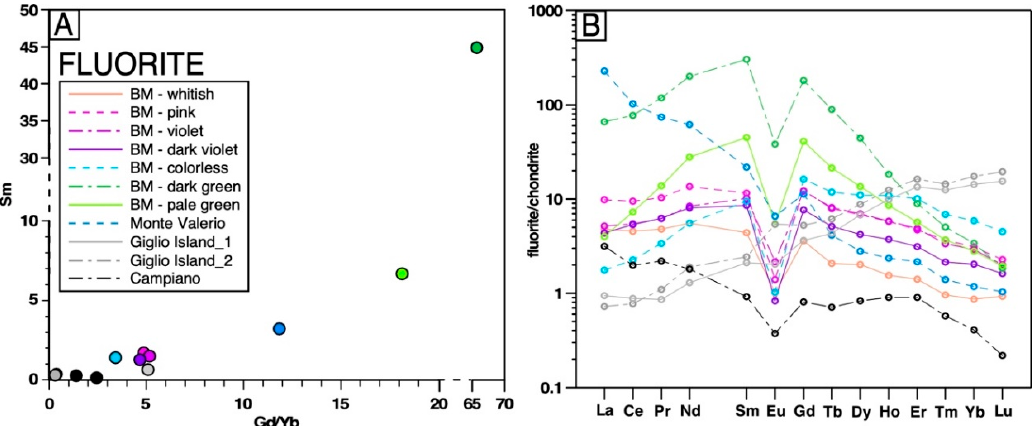
Figure 13. ( A ) Sm vs. Gd/Yb diagram showing an overall positive correlation, with higher values in the green crystals. ( B ) Chondrite normalized REE pattern for fluorite from the Campiglia system. Monte Valerio and Giglio Island fluorite are analyzed for comparison. Colors of symbols and lines correspond to fluorite crystal colors. Chondrite normalization values are taken from reference [25].